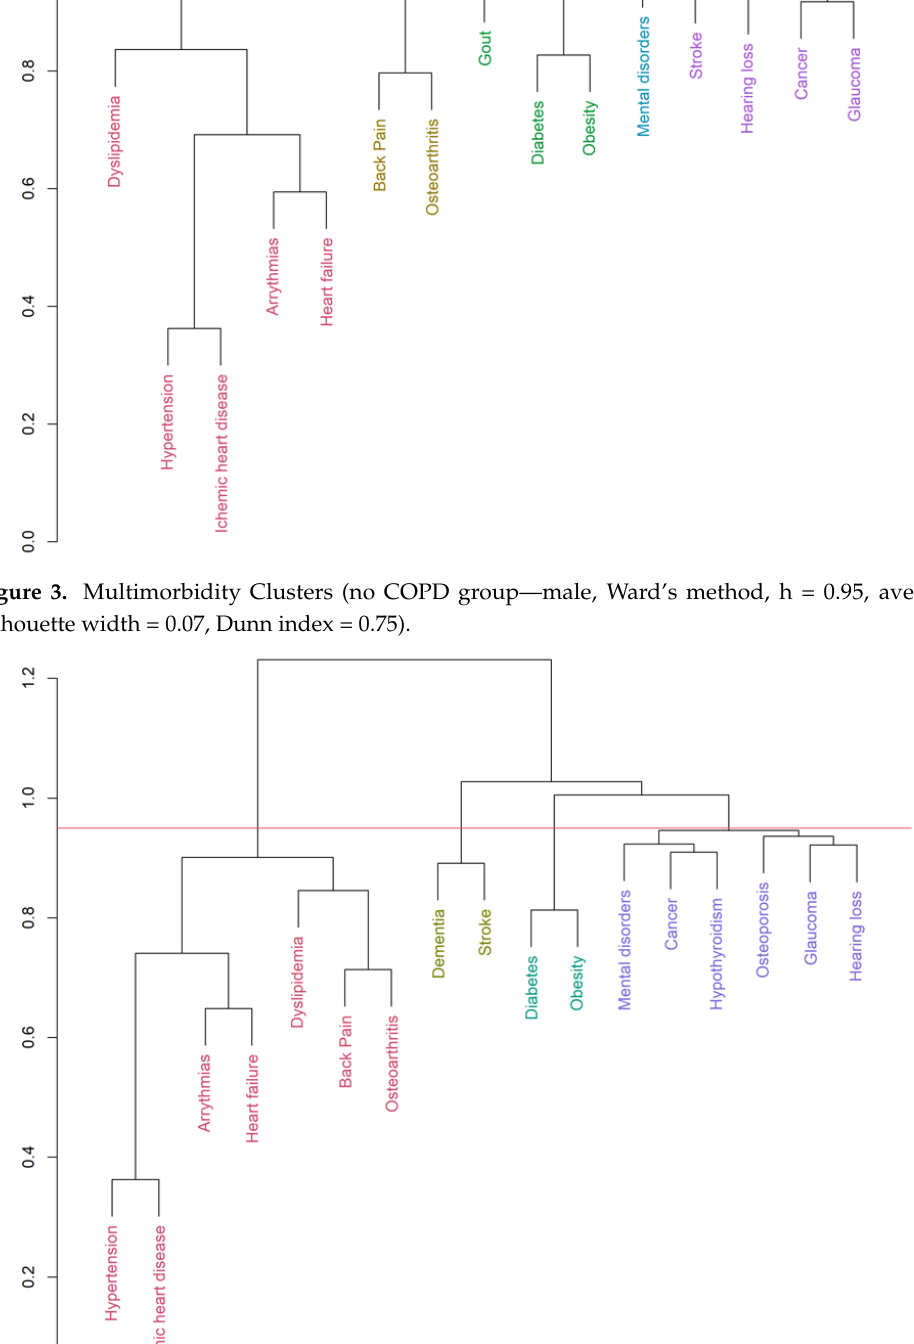
Figure 4. Multimorbidity clusters (no COPD group—female). (Ward’s method, h = 0.95, average Silhouette width = 0.06, Dunn index = 0.73).